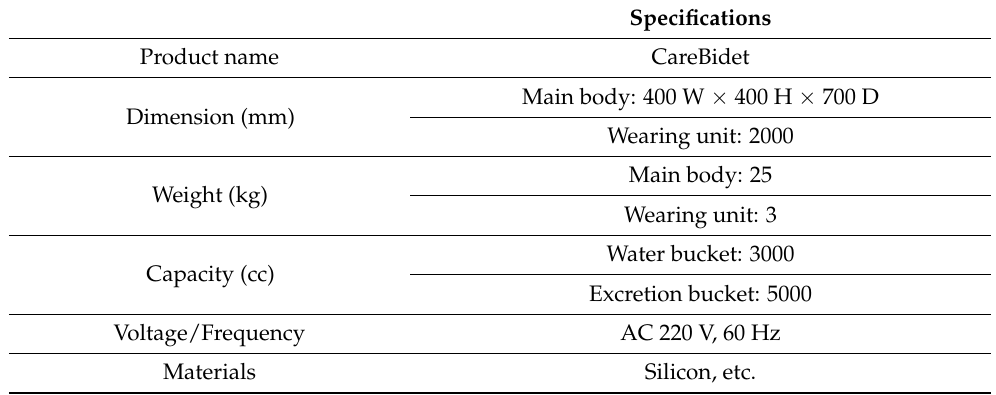
Table 1. The specifications of CareBidet.